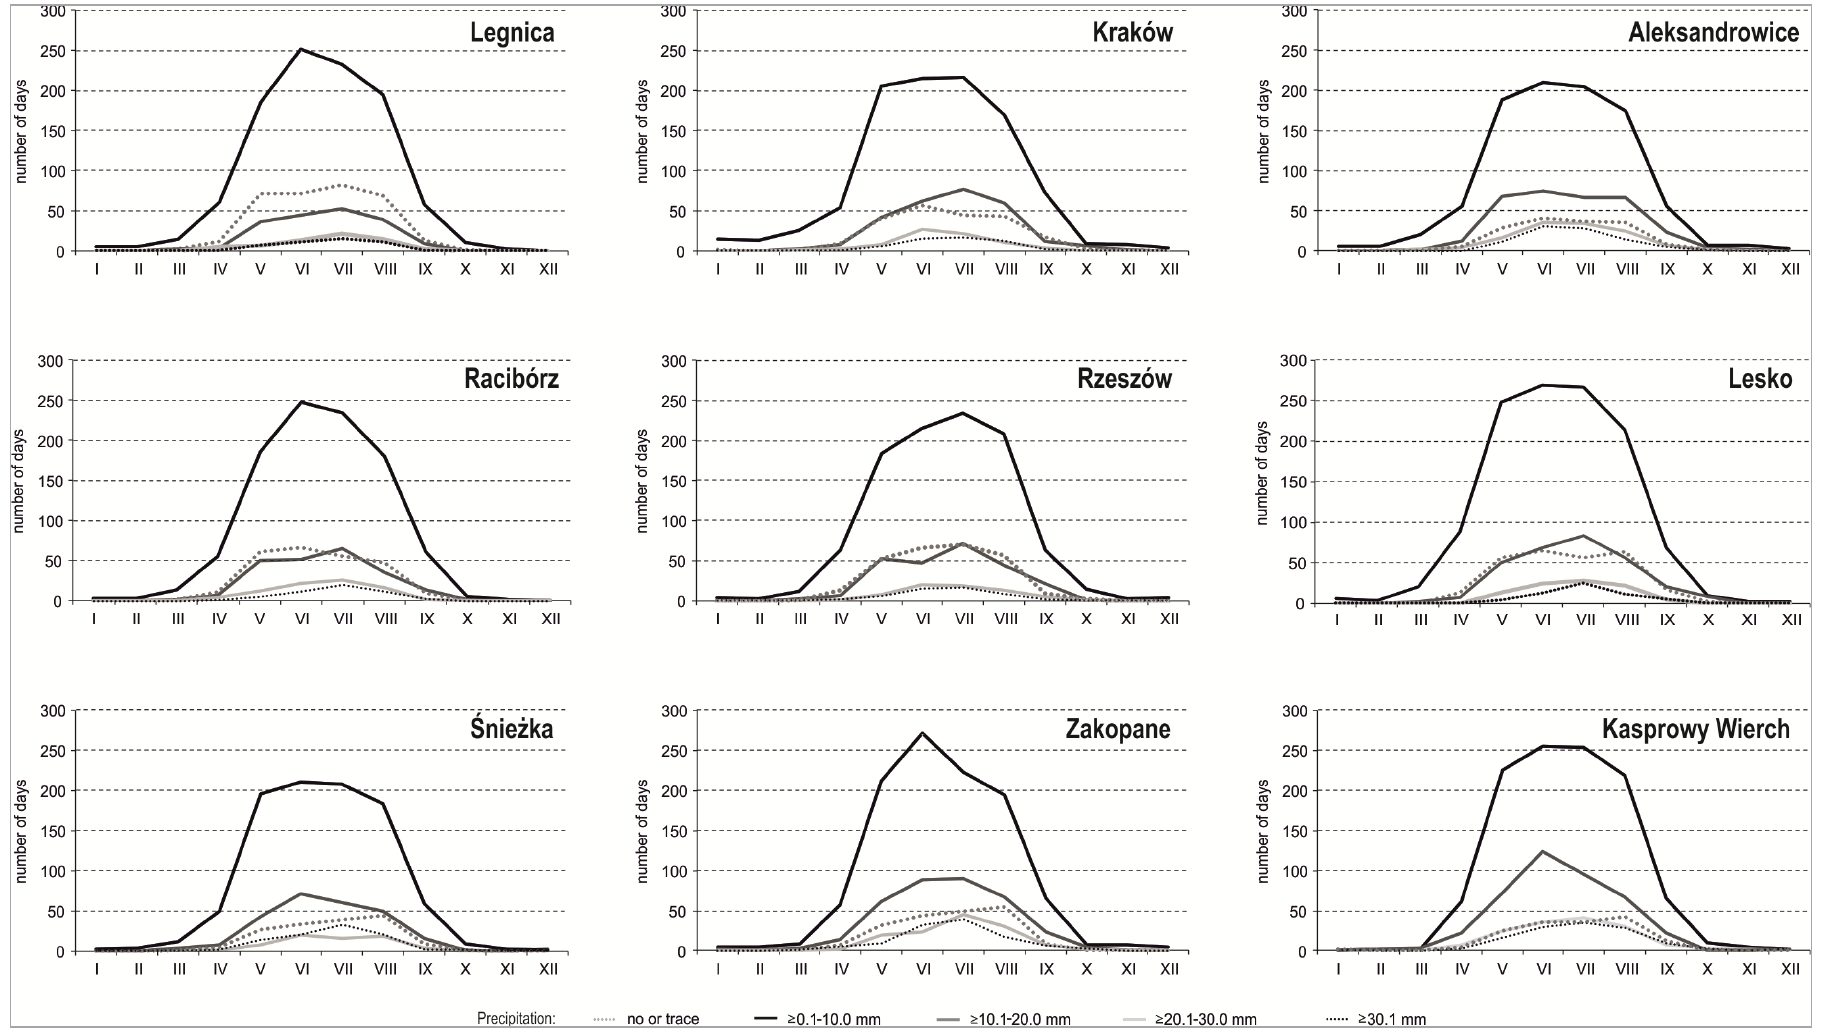
Fig. 3. Number of thunderstorm days with different precipitation categories in the period 1951-2010 – annual